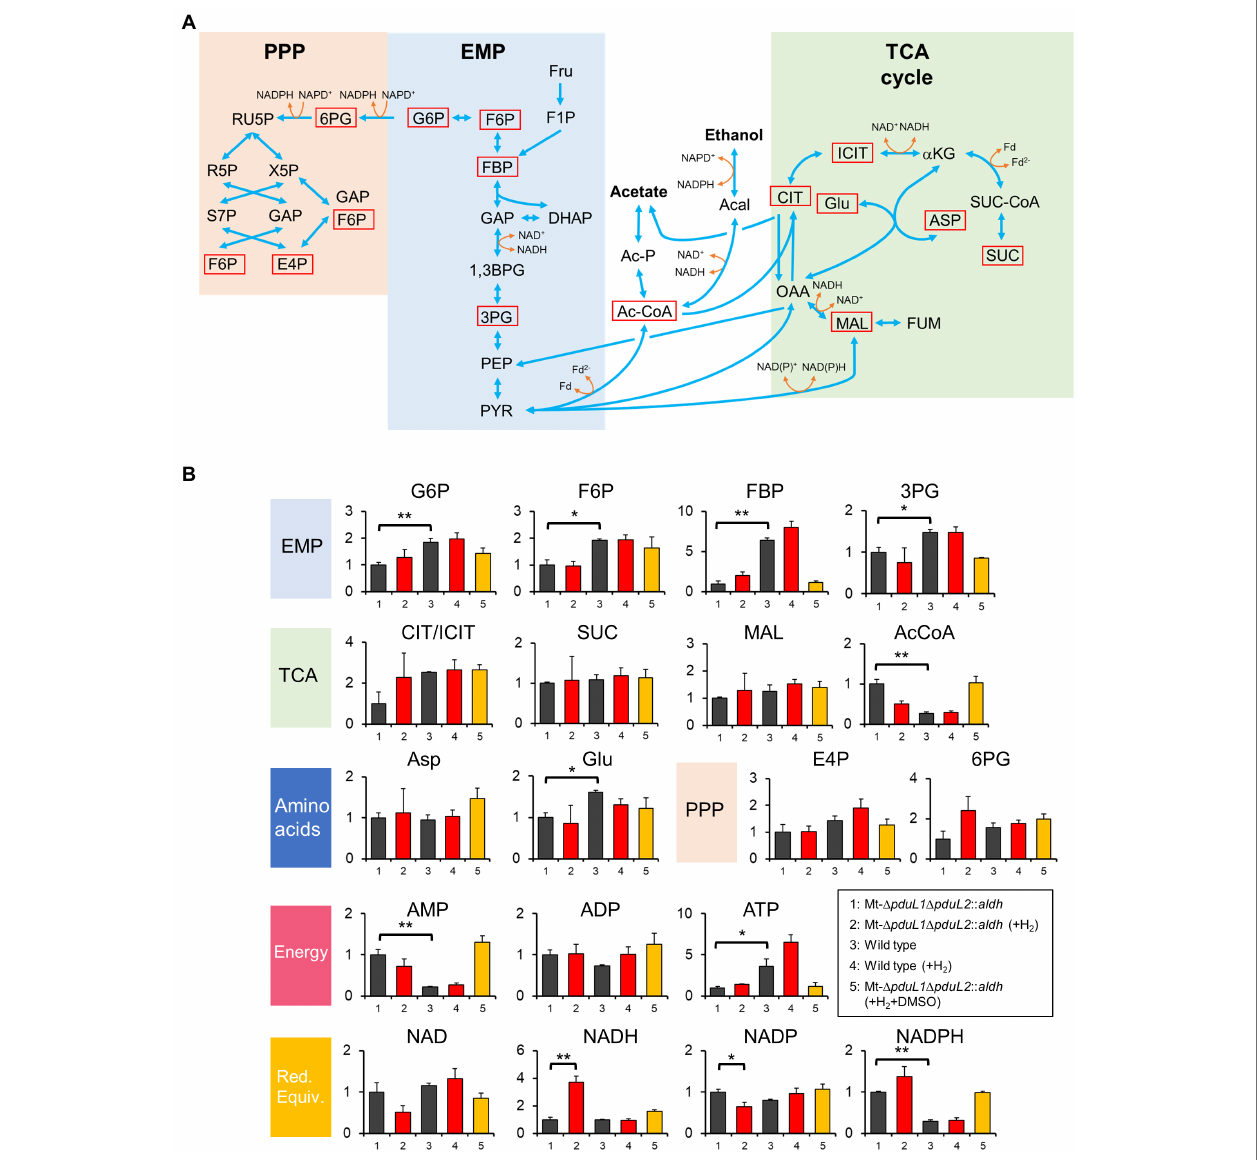
FIGURE 3 | Metabolome analysis of the Mt- Δ pduL1 Δ pduL2 :: aldh strain and the wild-type strain with and without H 2 supplementation. (A) Metabolic pathways for the Moorella thermoacetica strains based on KEGG database (https://www.genome.jp/kegg-bin/show_organism?org=mta) and a previous study on a metabolic model (Islam et al., 2015). Metabolites quantified except for cofactors are shown by red squares. EMP, Embden–Meyerhof–Parnas pathway; PPP, pentose phosphate pathway; Fru, fructose; F1P, fructose 1-phosphate; G6P, glucose-6-phosphate; F6P, fructose 6-phosphate; FBP, fructose-1,6-bisphosphate; GAP, glyceraldehyde 3-phosphate; DHAP, dihydroxyacetone phosphate; 1,3BPG, 1,3-bisphosphoglyceric acid; 3PG, 3-phosphoglyceric acid; PEP, phosphoenolpyruvic acid; PYR, pyruvate; X5P, xylulose 5-phosphate; RU5P, ribulose 5-phosphate; R5P, ribose 5-phosphate; S7P, sedoheptulose 7-phosphate; E4P, erythrose 4-phosphate; Ac-CoA, Acetyl- CoA; Ac-P, acetyl phosphate; Acal, acetaldehyde; CIT, citrate; ICIT, isocitrate; α KG, alpha-ketoglutarate; SUC-CoA, succinyl-CoA; SUC, succinate; Glu, glutamate; OAA, oxaloacetic acid; MAL, malate; FUM, fumarate; ASP, aspartate; GAP, glyceraldehyde 3-phosphate. (B) Relative concentrations of intracellular metabolites for the Mt- Δ pduL1 Δ pduL2 :: aldh strain and the wild-type strain in the absence (black) and presence of H 2 (0.02 MPa, red) on fructose as the carbohydrate substrate. The experiment with DMSO supplementation in addition to H 2 is shown in orange. All the cell samples were collected at around 0.6 of OD 600 . DMSO was added at 0.4 of OD 600 . For each sample, values were normalized to the Mt- Δ pduL1 Δ pduL2 :: aldh strain without H 2 supplementation. The vertical axis represents a unitless ratio of metabolite concentrations. Error bars represent the SD of at least two biological replicates. Red. Equiv. represents reducing equivalents. t -test was performed to evaluate the significance between data sets 1 and 2, data sets 3 and 4, and data sets 1 and 3. Significant differences are shown. value of * p <0.05; value of ** p